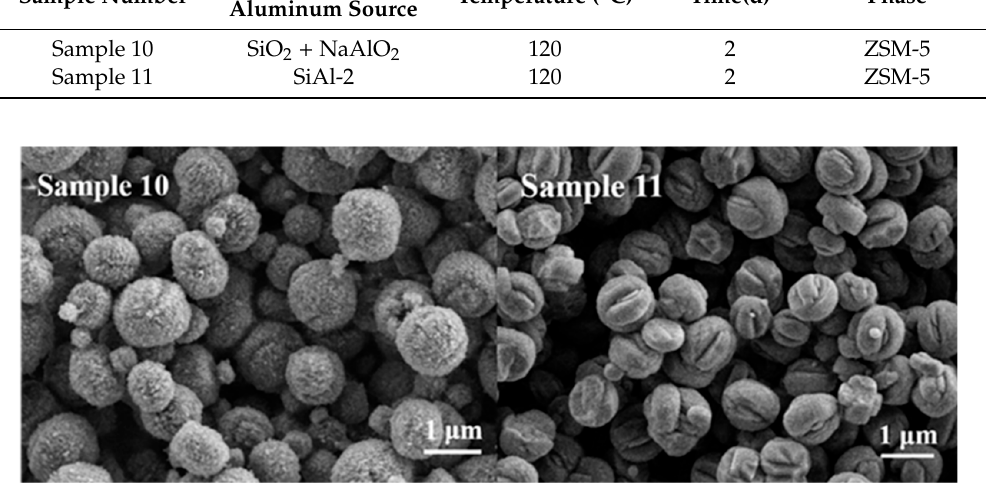
Figure 7. SEM images of Samples 10 and 11.